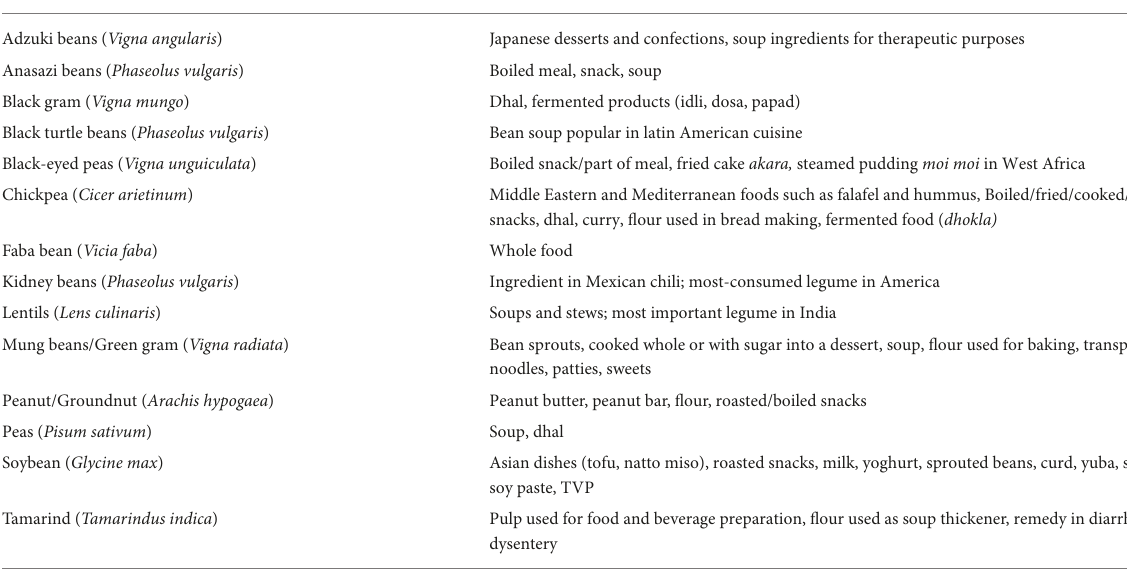
TABLE 4 Food uses of different legumes across the